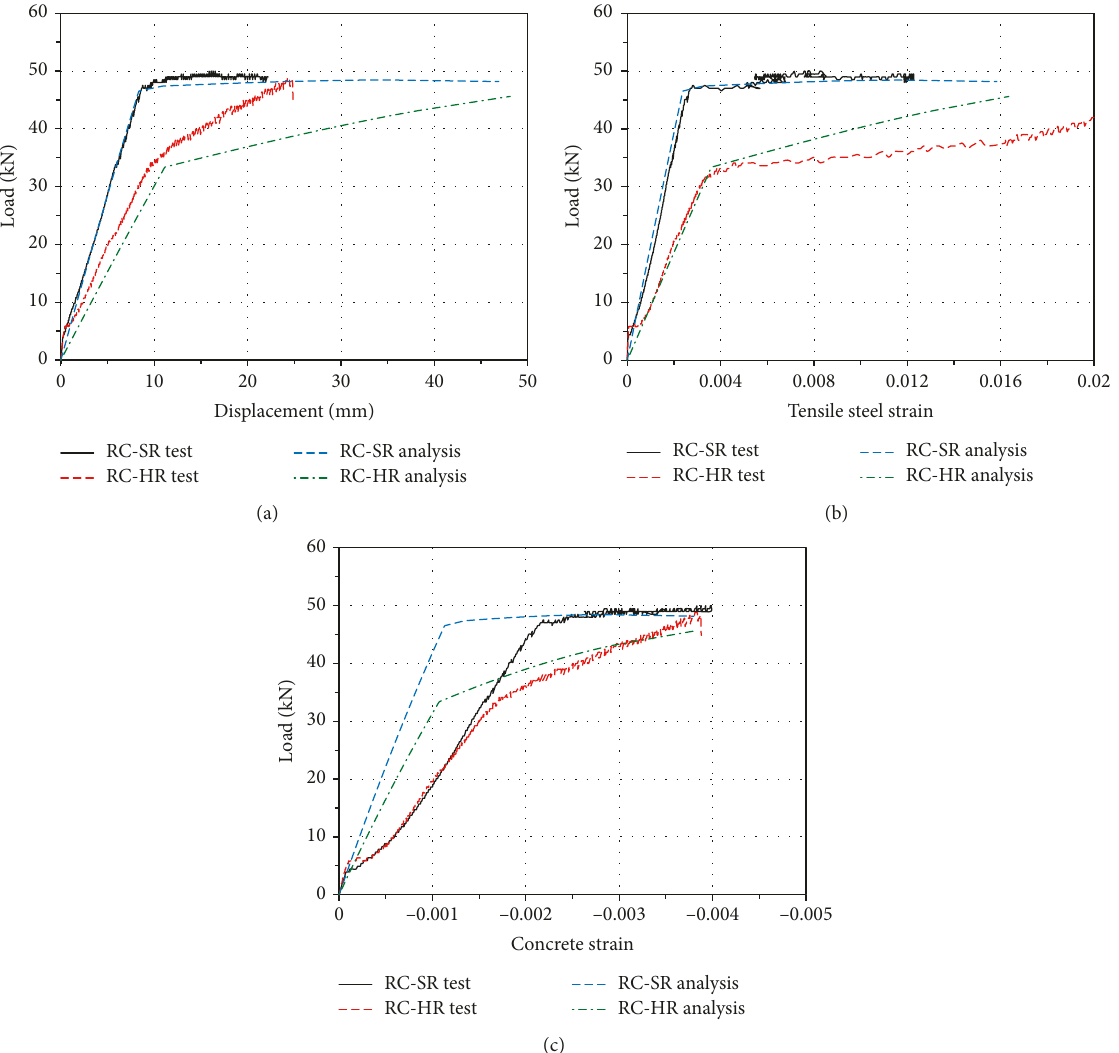
Figure 13: Comparison of predicted and experimental static flexural behaviors of RC beam specimens reinforced by the steel rebar (RC-SR) and by the hybrid FRP-steel rebar (RC-HR): (a) load-deflection curves at midspan; (b) load-tensile strain curves in longitudinal re- inforcement; (c) load-concrete compressive strain